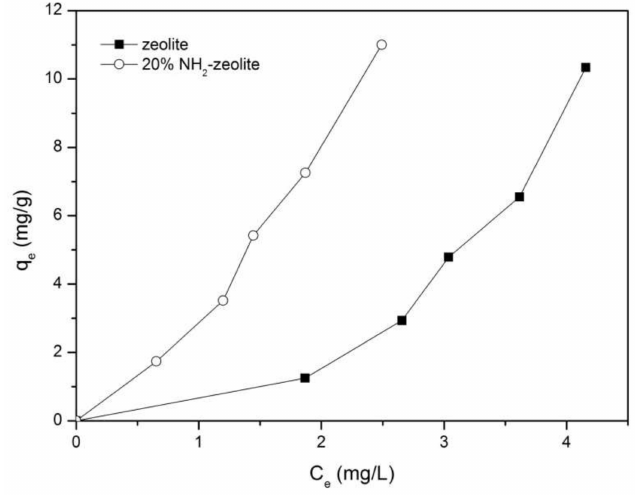
Figure 14. Isotherm for adsorption of naphthalene onto the zeolite and amino functionalized zeolite samples.